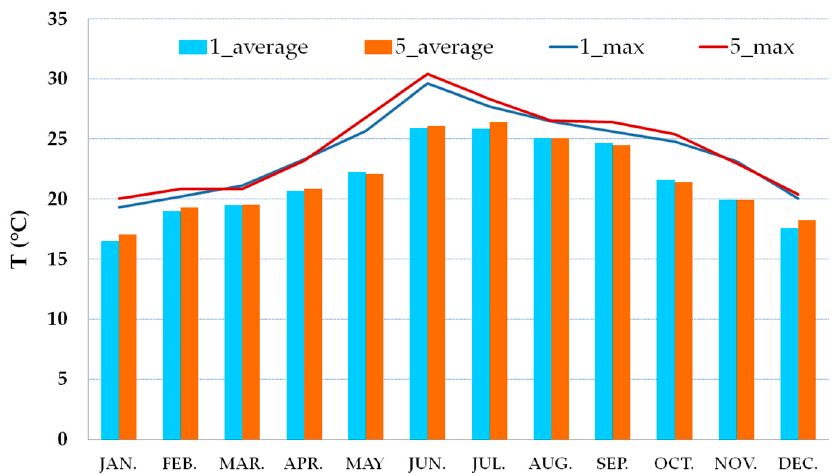
Figure 7. Monthly average and maximum temperature values measured at points 1 (inside showcase) and 5 (in the room).